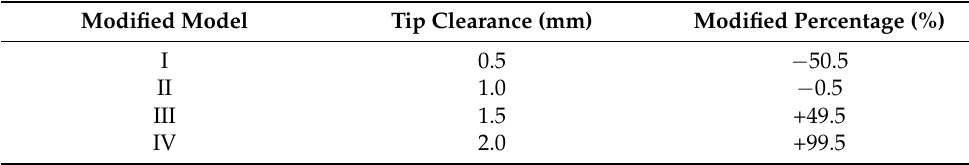
Table 2. Parameters of ducted propellers.